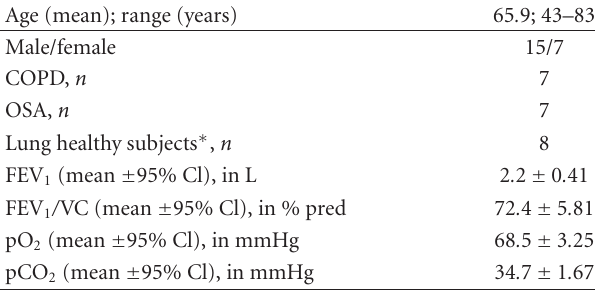
Figure 1: TNF- α - and EPO levels in exhaled breath condensate (EBC) from 13 nonhypoxic subjects in which both markers could be detected simultaneously, horizontal line =